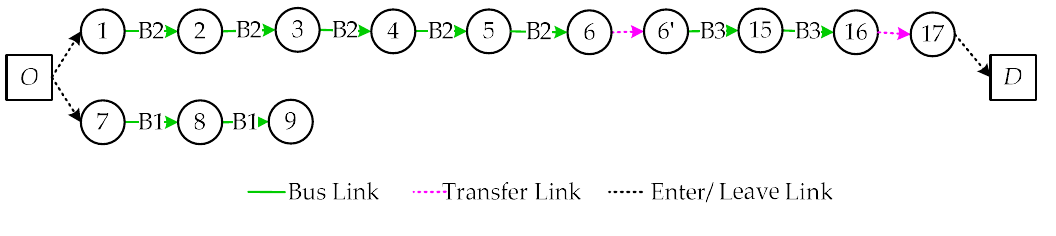
Figure 4. The bus super network topology.